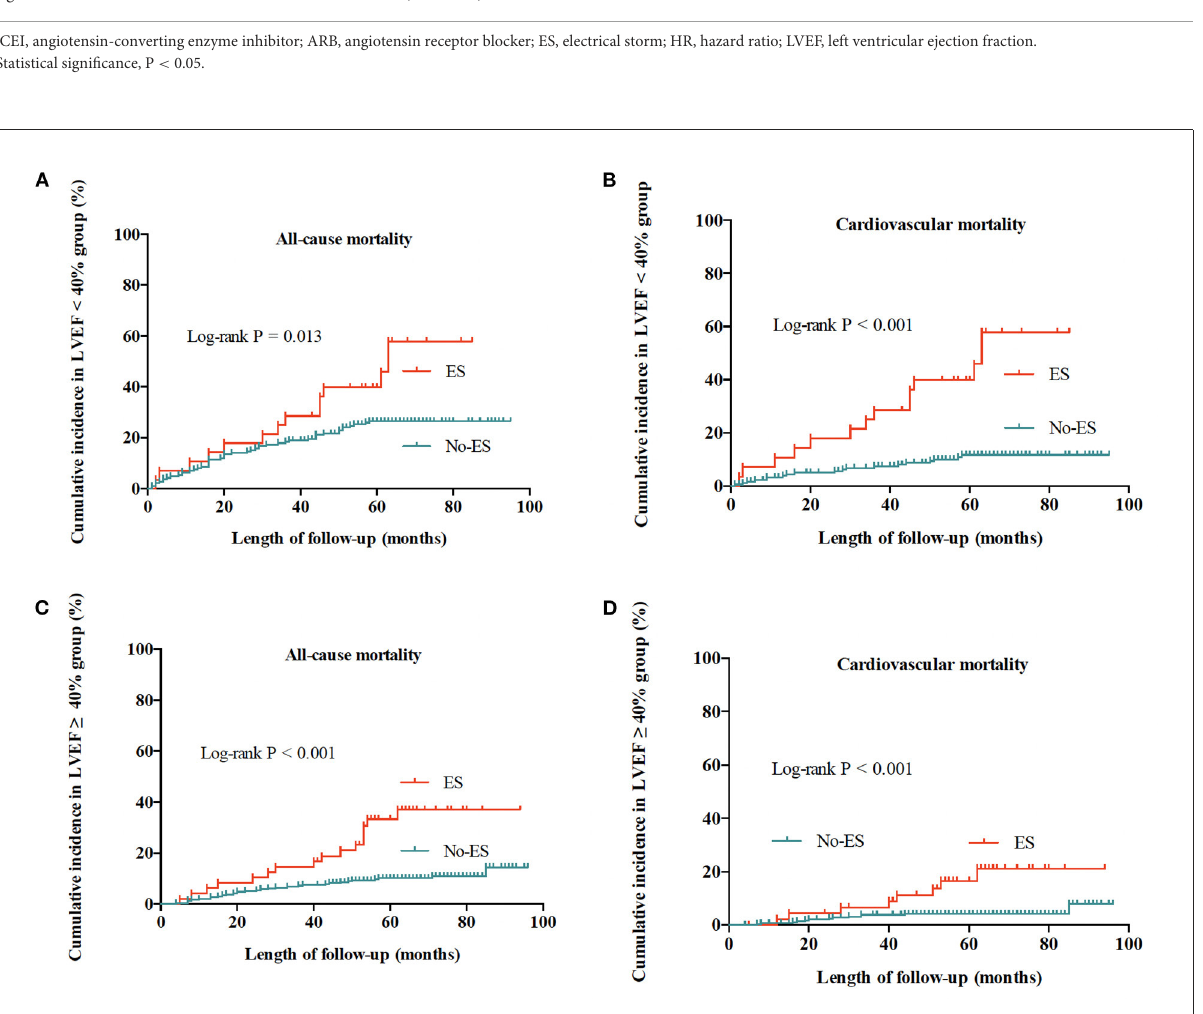
FIGURE3 Cumulative incidences of all-cause and cardiovascular mortality for patients with preserved LVEF ( ≥ 40%) and impaired LVEF ( < 40%). (A) All-cause mortality for patients with impaired LVEF. (B) Cardiovascular mortality for patients with impaired LVEF. (C) All-cause mortality for patients with preserved LVEF. (D) Cardiovascular mortality for patients with preserved